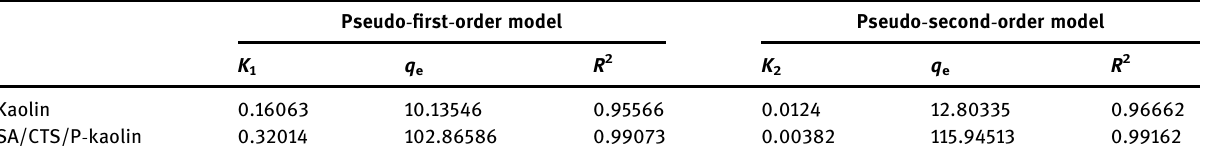
Pseudo - fi rst - order model